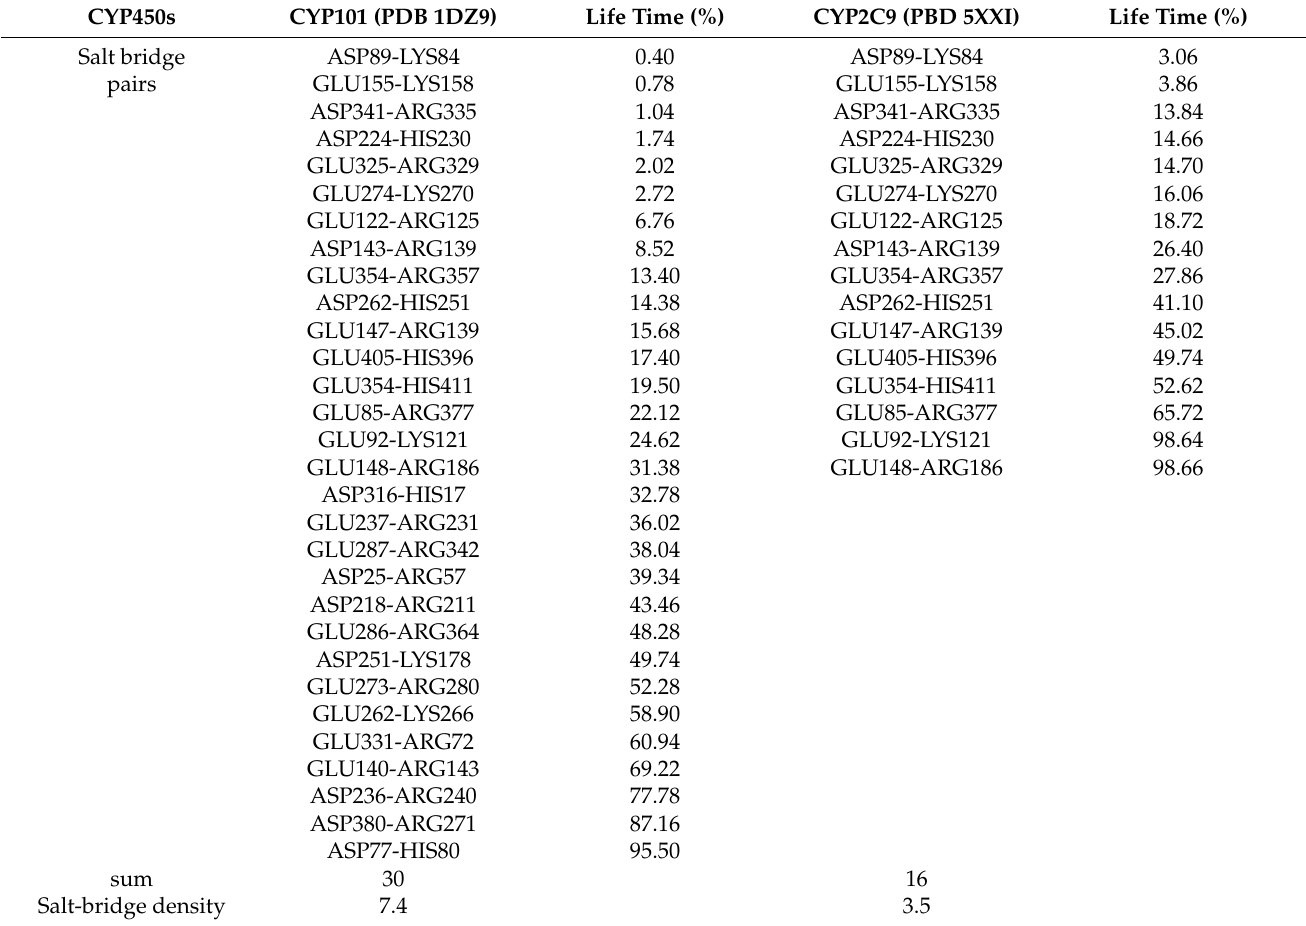
Table 1. The average life time of salt-bridge pairs in CYP101 and CYP2C9 obtained from 500 ns